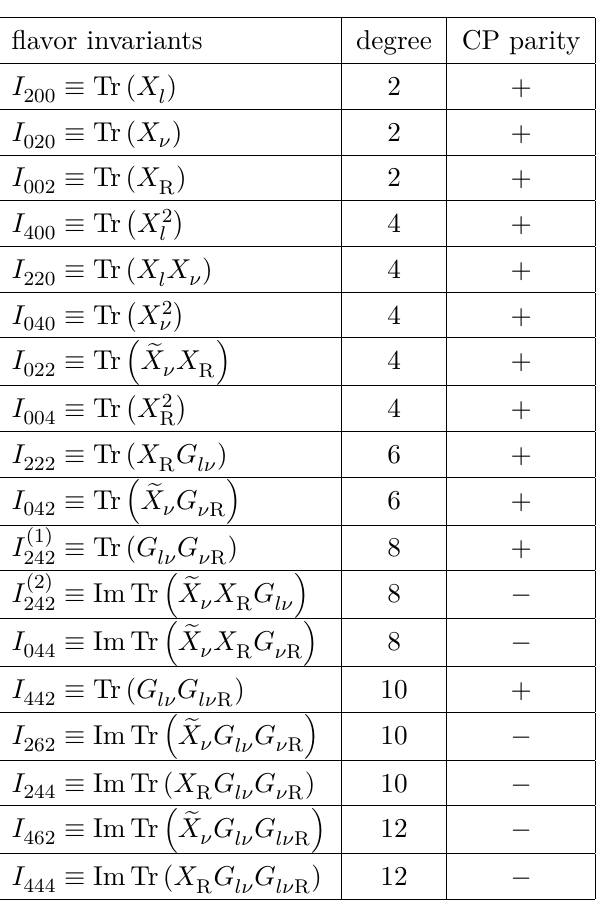
Table 4 . Summary of the basic flavor invariants along with their degrees and CP parities in the full seesaw model for two-generation case, where the subscripts of the invariants denote the degrees of Y , Y and Y , respectively. Note that we have also defined some building blocks that transform ν R l adjointly under the flavor transformation: X